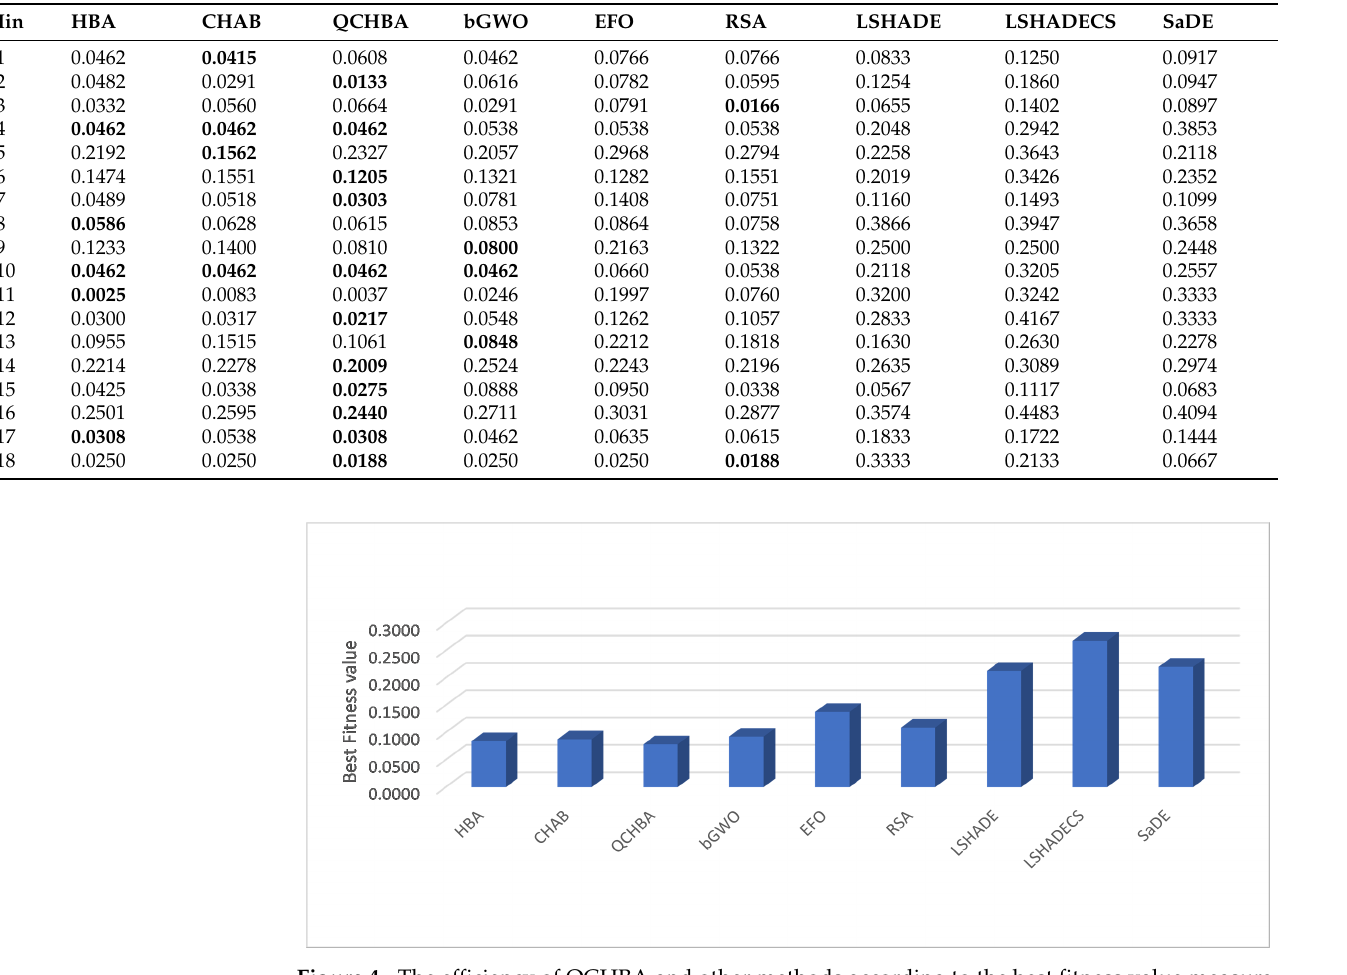
Figure 4. The efficiency of QCHBA and other methods according to the best fitness value measure. Table 5. Worst fitness values generated using competitive